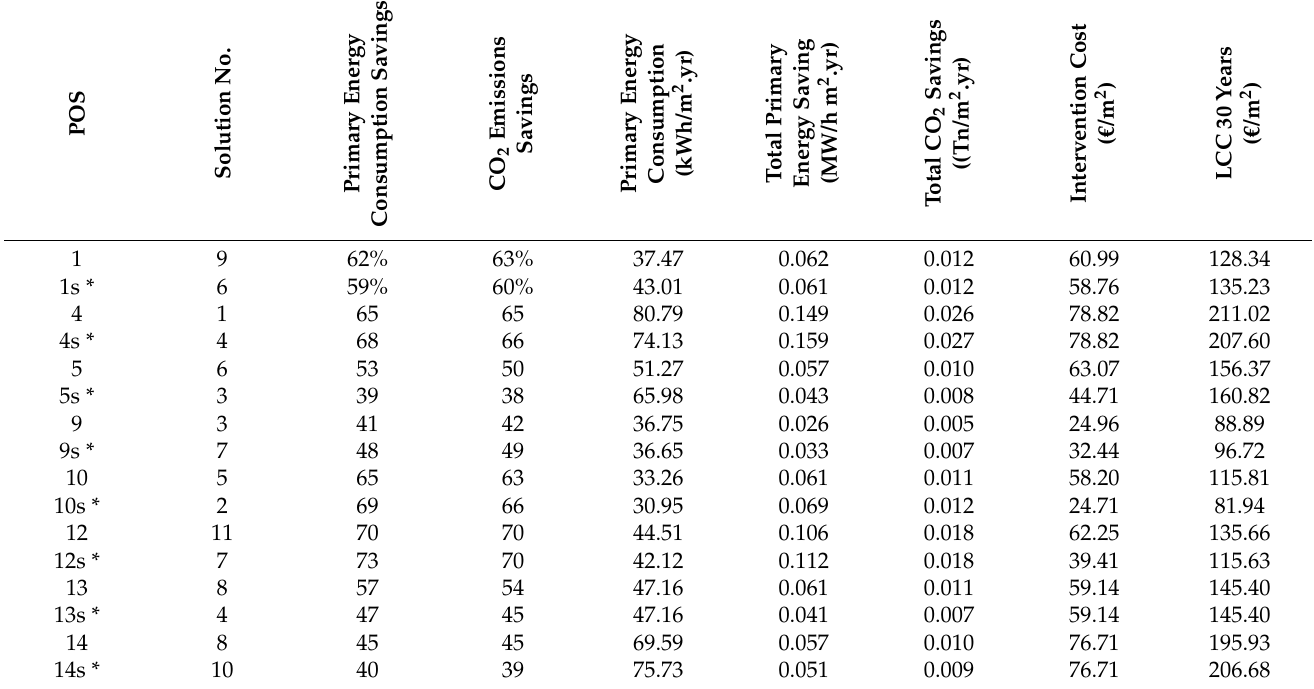
Table 10. Selected solutions from the results of all the POS applicable to the building stock.